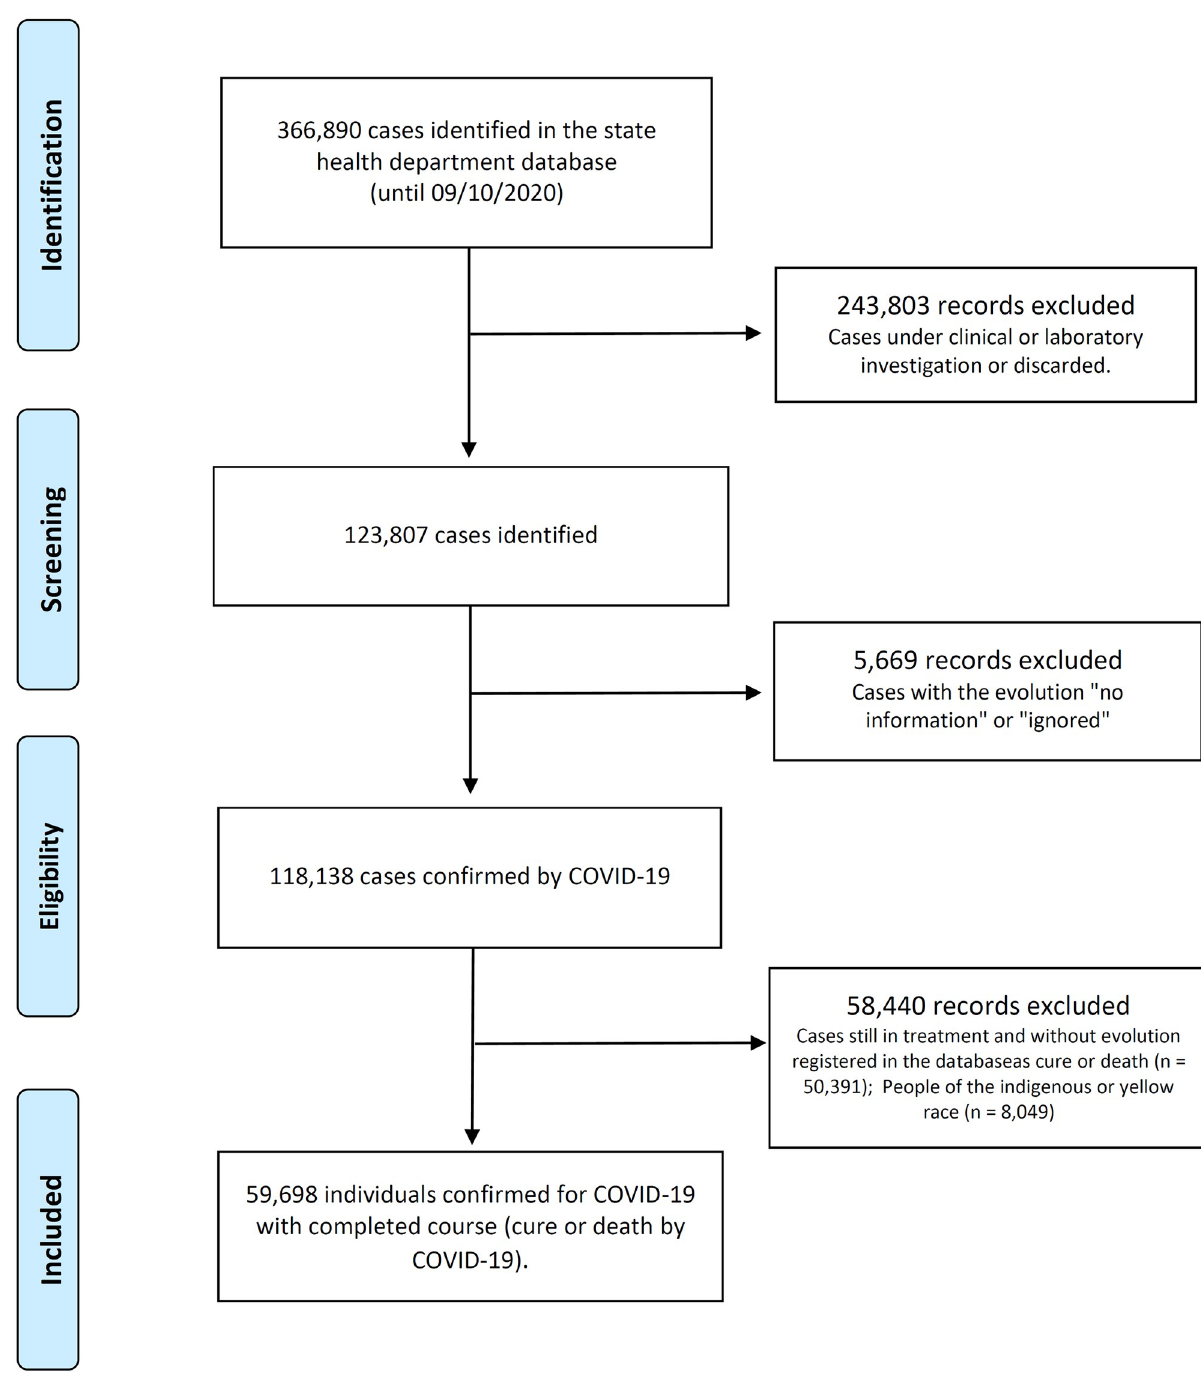
Fig 1. Flow diagram of the selection of individuals participating in the